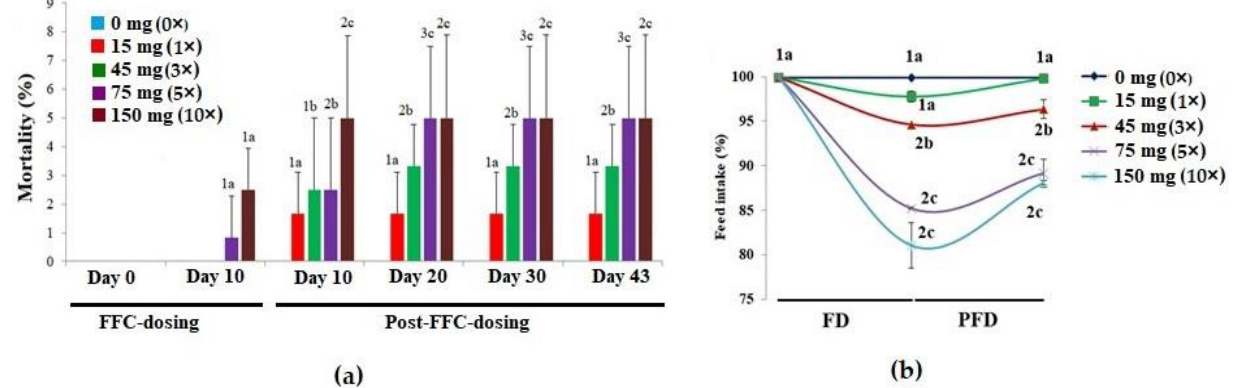
Figure 1. The effects of oral florfenicol (FFC) dosing at 0 – 10 times the therapeutic dose of 15 mg kg biomass −1 day −1 for 10 consecutive days on the ( a ) mortality and ( b ) feed intake of Oreochromis nilot- icus juveniles. a – c : Bars of a particular day showing common alphabets differed insignificantly ( p > 0.05). 1 – 3: Bars of a particular treatment (dose) showing common numerals differed insignificantly